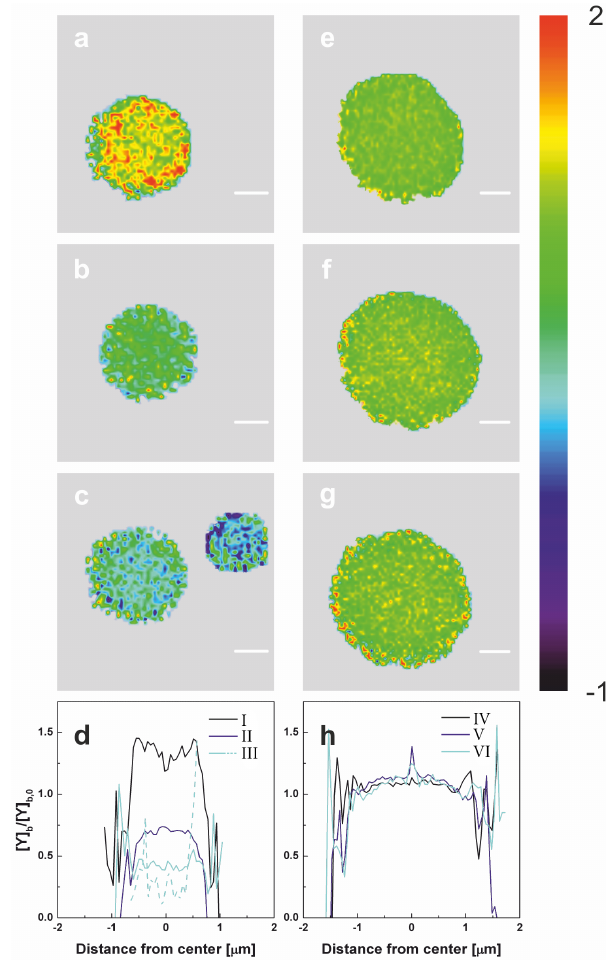
Figure 6. Depletion of shikimic acid via the decrease of OD at the maximum of the 1s- π ∗ transition peak around 284.4eV nor- malized to total carbon. (a–c) show the progress of the reaction for four different particles at 71% RH at O 3 doses of 0atms (a) , 5 . 0 × 10 − 2 atms (b) and 7 . 7 × 10 − 2 atms (c) . (d) depicts the re- spective radial profiles of the particles: (I) (black line), (II) (dark blue line) and (III) (light blue lines, solid (larger particle) and dashed (smaller particle)). (e–g) show the progress of the reaction for three different particles at 12% RH with O 3 doses of 0atms (e) , 1 . 4 × 10 − 2 atms (f) and 7 . 9 × 10 − 2 atms (g) . (h) depicts the radial profiles of the imaged particles: (IV) (black line), (V) (dark blue line) and (VI) (light blue line). The scale bar denotes 500nm. The the appearance of clusters of red pixels at the edge of some of the particles arises from alignment issues combined with the rela- tively low contrast of the carbon K-edge measurements. The images show that no observable concentration gradient has formed at either